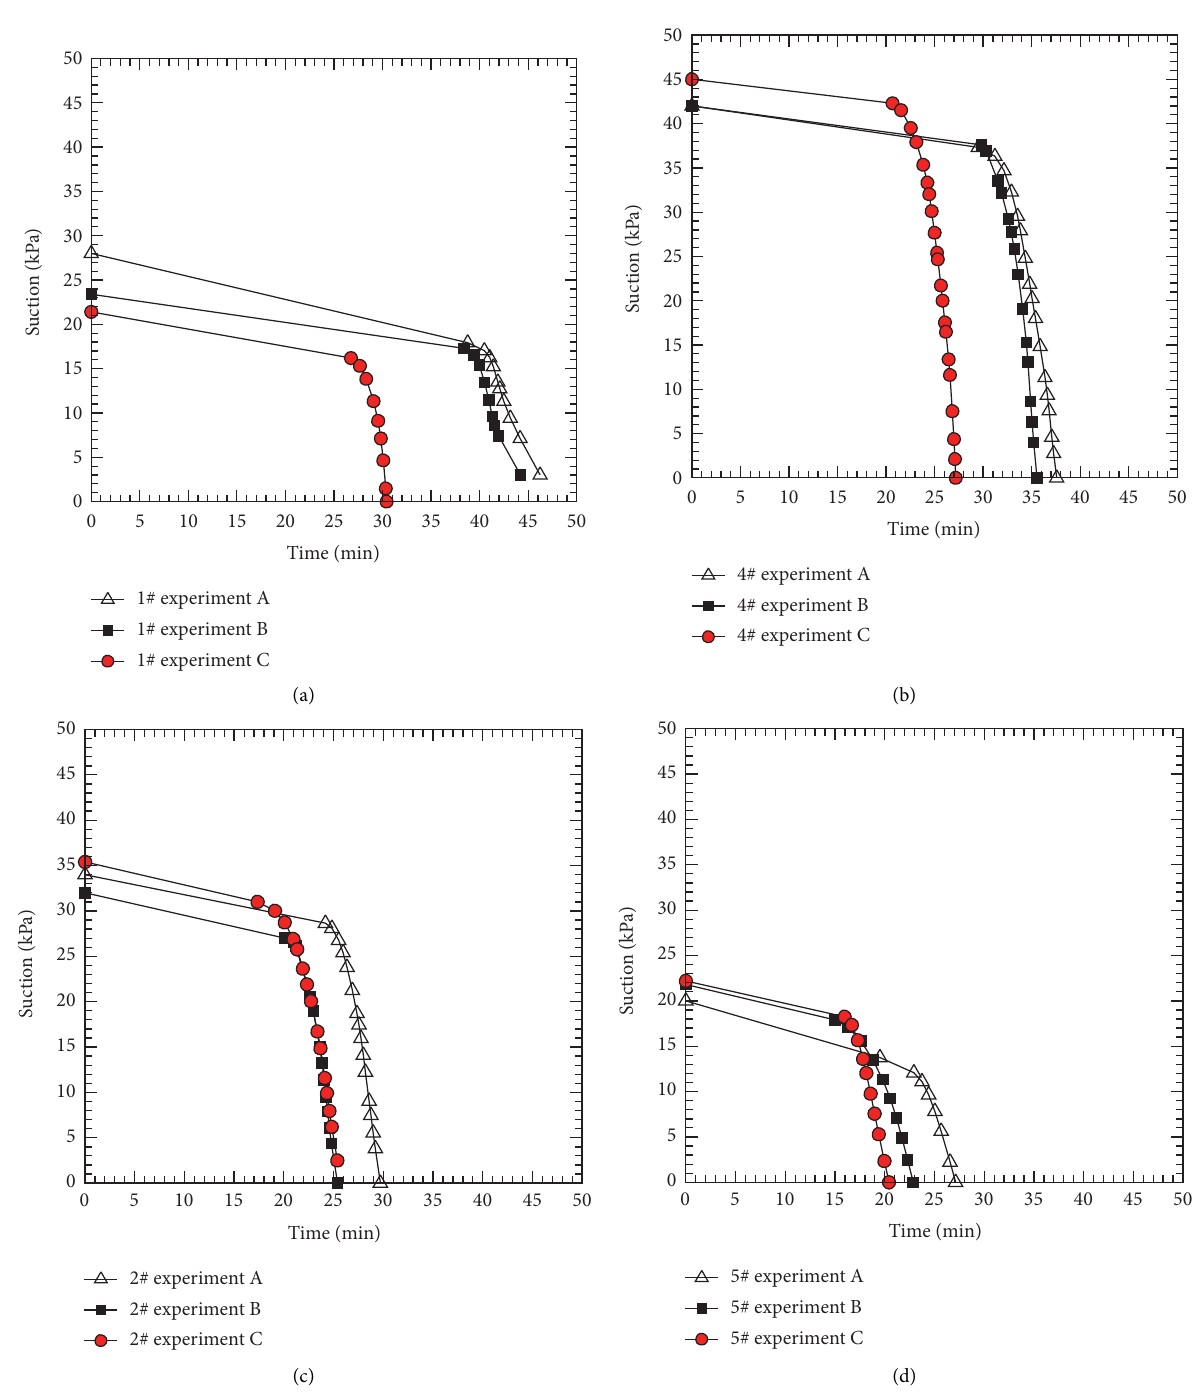
Figure 3: Evolution of matrix suction measured with tensiometers located at various depths of: (a) 1# (250mm depth); (b) 4# (250mm depth); (c) 2# (150 mm depth); (d) 5# (150 mm